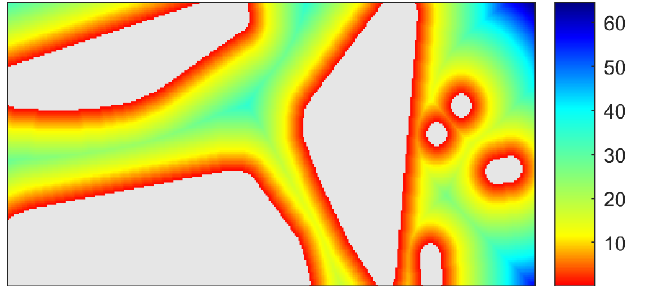
Figure 17. An example of the occupied grid map (OGM) distance